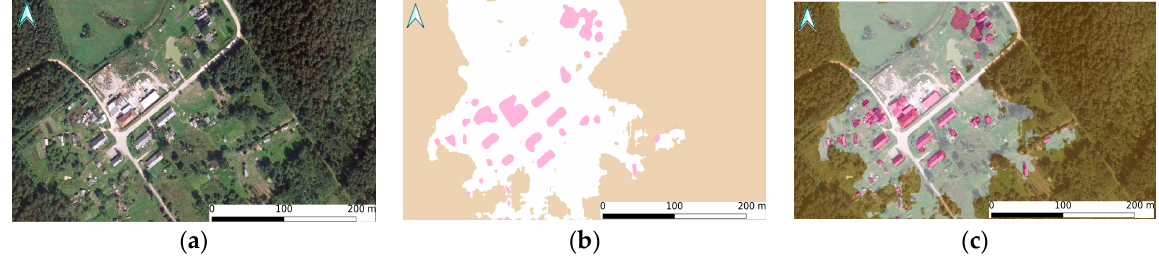
Figure 11. The example of inference using image from 2009–2010 dataset with a random position: ( a ) original ORTO10 view; ( b ) inference results; ( c ) overlay of original image and transparent inference results.